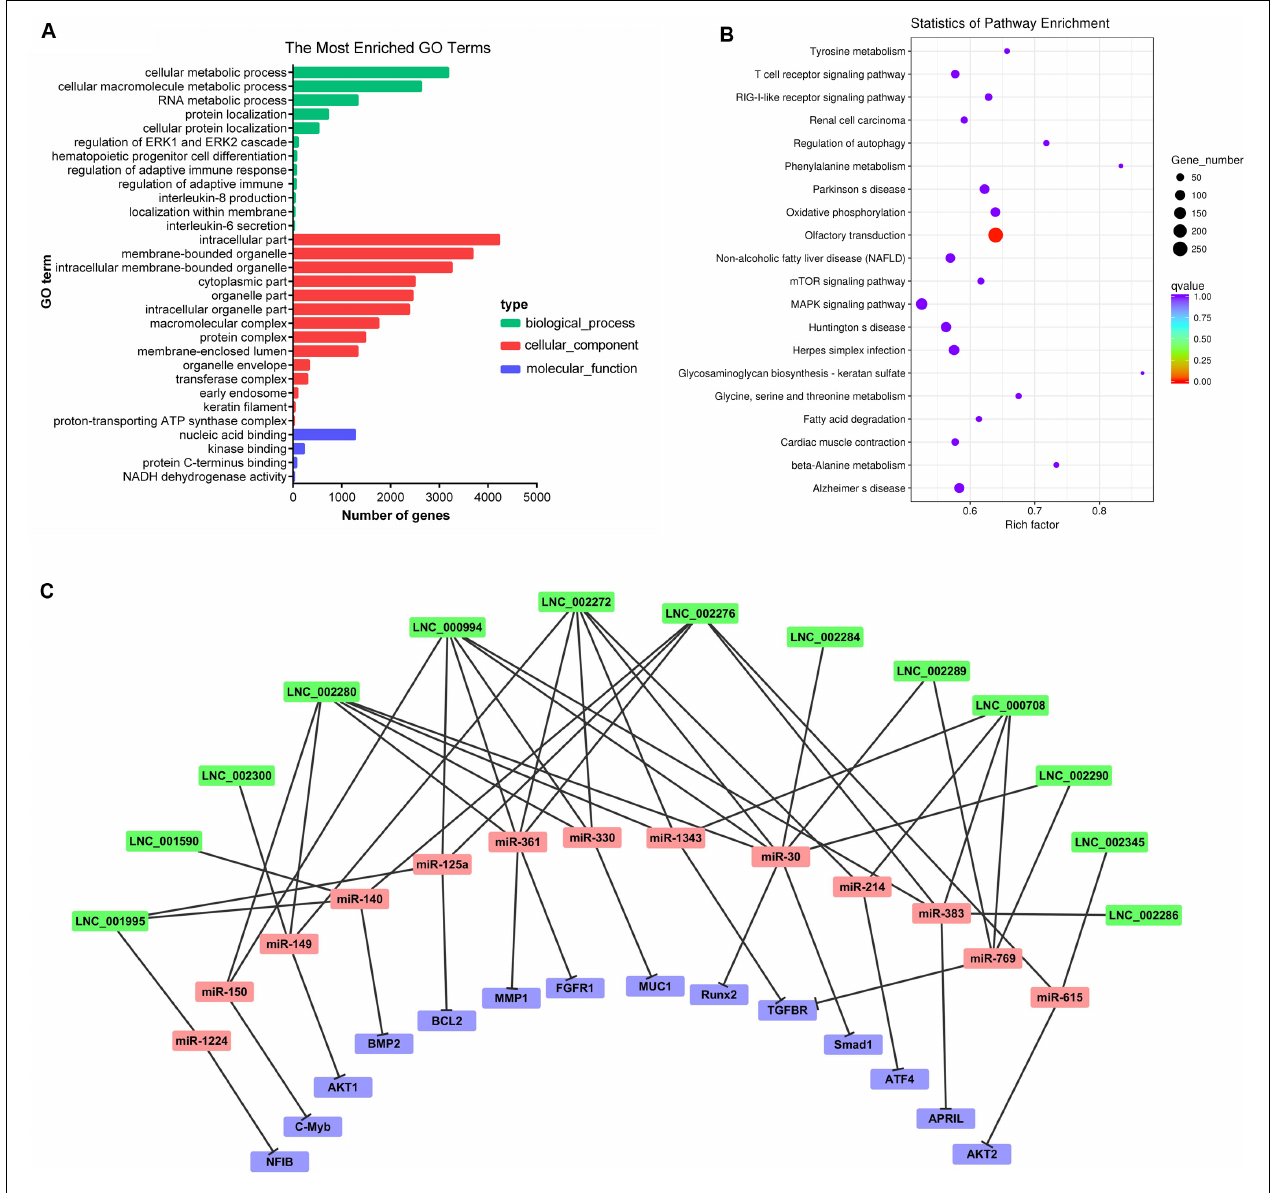
FIGURE 4 | Cluster analysis and enrichment analysis of porcine milk exosomes (PME) lncRNAs. (A) Gene Ontology annotation analysis of PME lncRNAs. (B) Kyoto Encyclopedia of Genes and Genomes enrichment analysis of neighboring gene functions of PME lncRNAs. (C) lncRNA–miRNA–mRNA correlation network. The lncRNAs were depicted in green, the miRNAs in red, and the mRNAs in